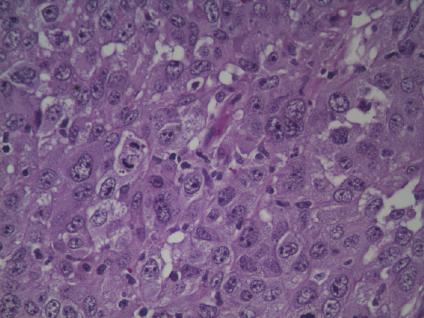
Figure 8: Infiltrating poorly differentiated carcinoma and surgical margin free of tumor. No ductal and no parenchymal tissues identified.